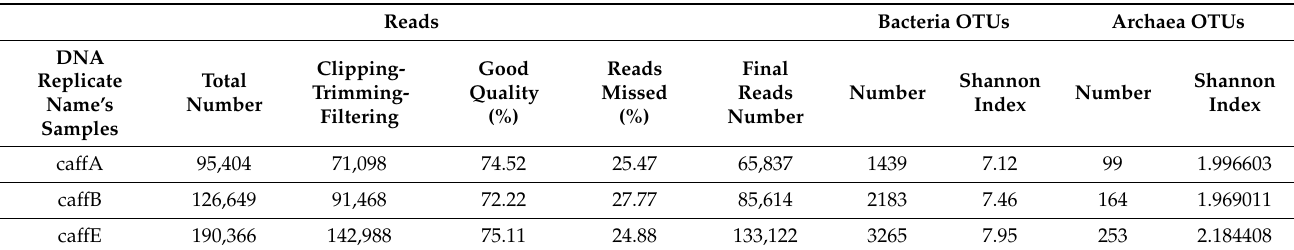
Table 2. Results of the next-generation sequencing, the number of good quality reads, and operational taxonomic units (OTUs) obtained from the data analysis. The retrieved diversity is associated with replicates of the sample. Reads